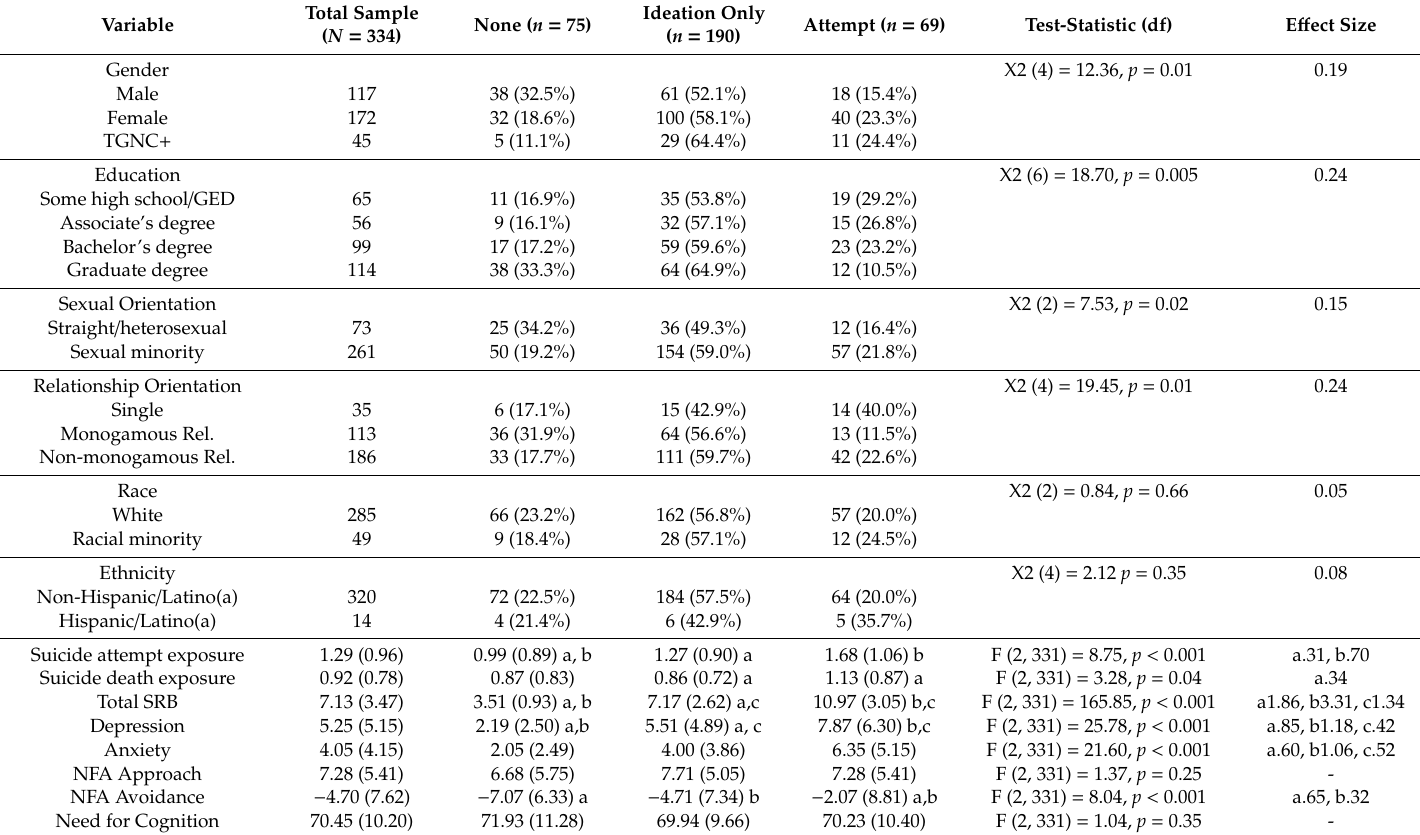
Table 2. Lifetime suicide-related behavior group variation in demographics, preferences in information processing, and mental health.